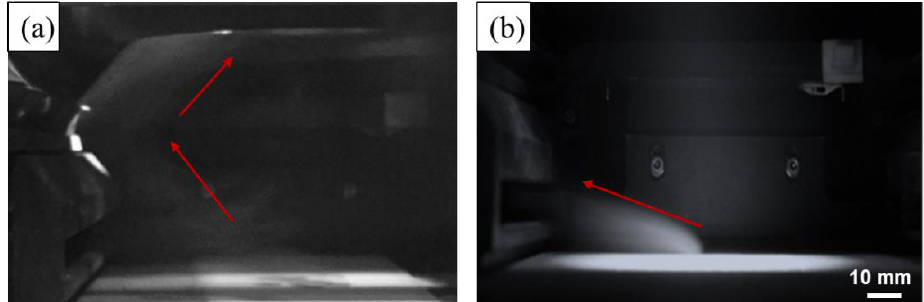
Figure 10. Evaporation fume captured during the LPBF of pure Zn, ( a ) insufficient shielding gas flow; ( b ) adequate shielding gas flow.